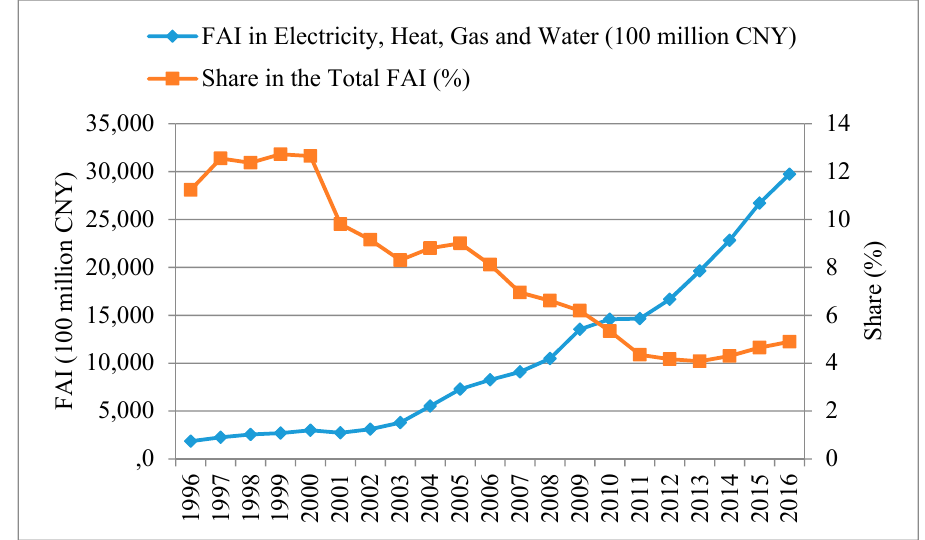
Figure 2. Fixed asset investments (FAI) in production and supply of electricity, heat, gas, and water (in urban areas), 1996–2016. Note: the data come from the National Bureau of Statistics of China.